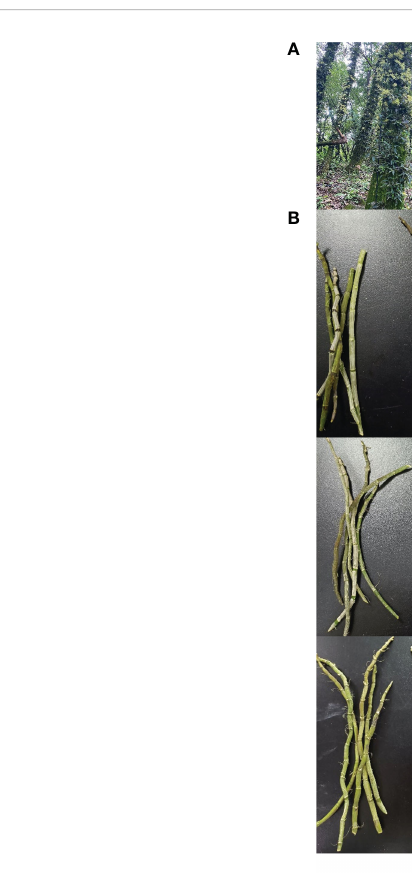
FIGURE 1 Agronomic traits of Dendrobium of fi cinale from different provenances. (A) Attached to the tree planting. (B) Photographs showing Dendrobium of fi cinale from different provenances, YN; ZJ; GZ. (C) fresh stem weight; (D) panel length; (E) fruit diameter; (F) stem length; (G) single stem weight. Different lowercase letters represent signi fi cant